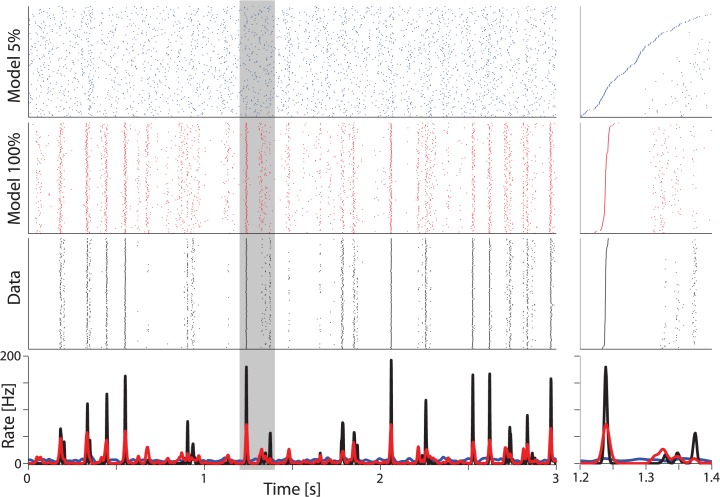
Interaction of synaptic input and intrinsic dynamics in spike prediction.Rasters show spike simulations from the model using a fixed set of presynaptic spikes as input across trials, alongside the observed spiking (“Data”) for 160 trials of a repeated stimulus segment. When only a small fraction (5%) of the presynaptic input is modeled spike predictions are highly variable from trial to trial (blue). However, when the full presynaptic input is modeled (red), the GLM more accurately reproduces the observed spike times (black). The predicted rates (bottom) match the observed PSTH, although with less precision. The panels on the right illustrate the difference in precision between the models and data for a small segment of the stimulus (gray box in left panels). Trials are sorted by time of the first spike.